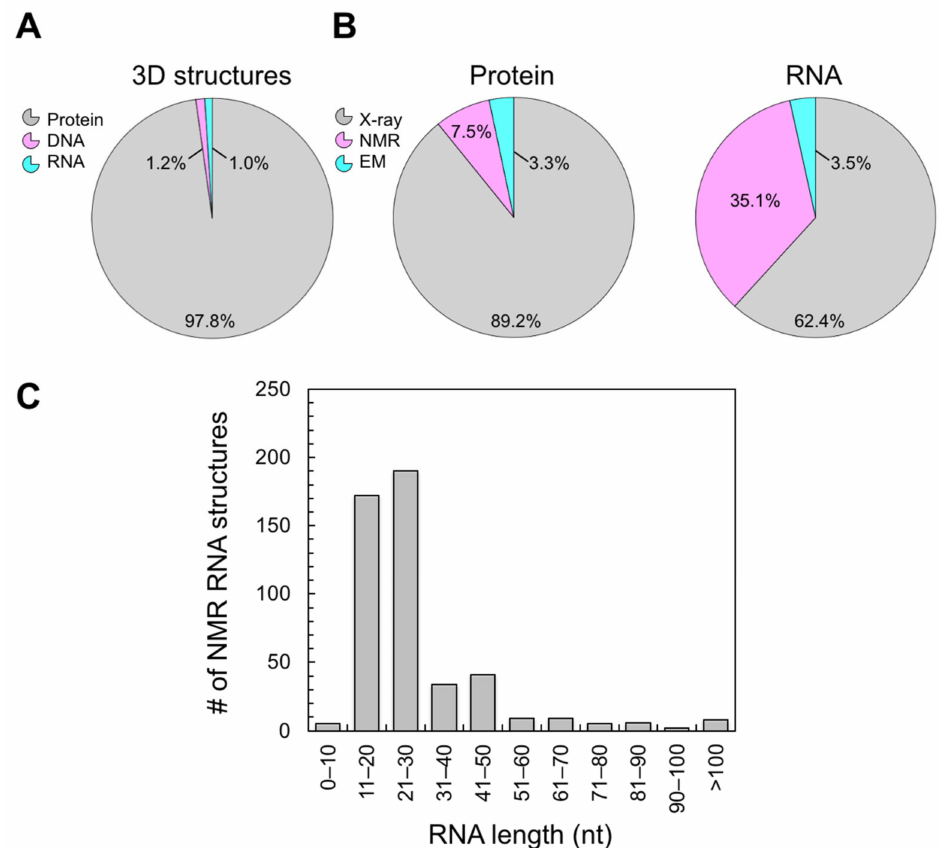
Figure 1. Structural biology statistics. The distribution of high-resolution 3D structures deposited in the PDB/NDB separated by ( A ) macromolecule type; and ( B ) protein and RNA structures separated by structure determination technique. ( C ) A histogram of RNA NMR structures in the NDB sorted by RNA length. Statistics were accessed in July